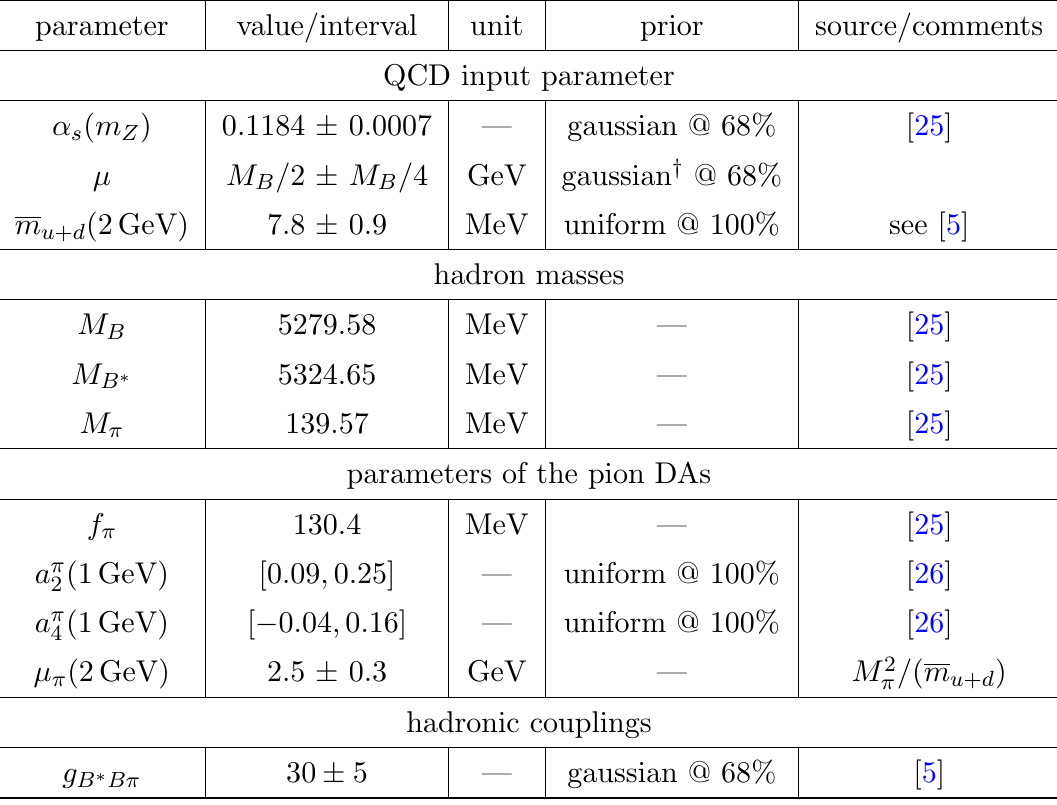
Table 1 . The input parameters used in our numerical analysis. We express the prior distribution as a product of individual priors that are either uniform or gaussian. The uniform priors cover the stated intervals with 100% probability. The gaussian priors cover the stated intervals with 68% probability, and the central value corresponds to the mode of the prior. For practical purposes, random variates of the gaussian priors are only drawn from their respective 99% probability inter- vals. The prior for the parameters describing the B (cid:25) form factor f + are not listed here and ! taken from [5]. : we restrict variates of the renormalization scale (cid:22) to the interval [ M B = 4 ; M B ] to y avoid unphysical